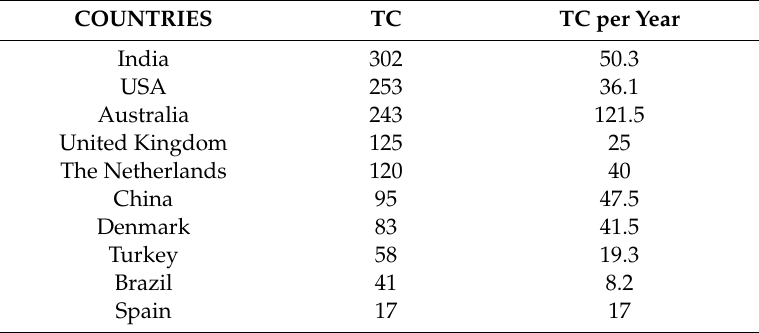
Table 7. Total citations (TC) per country.